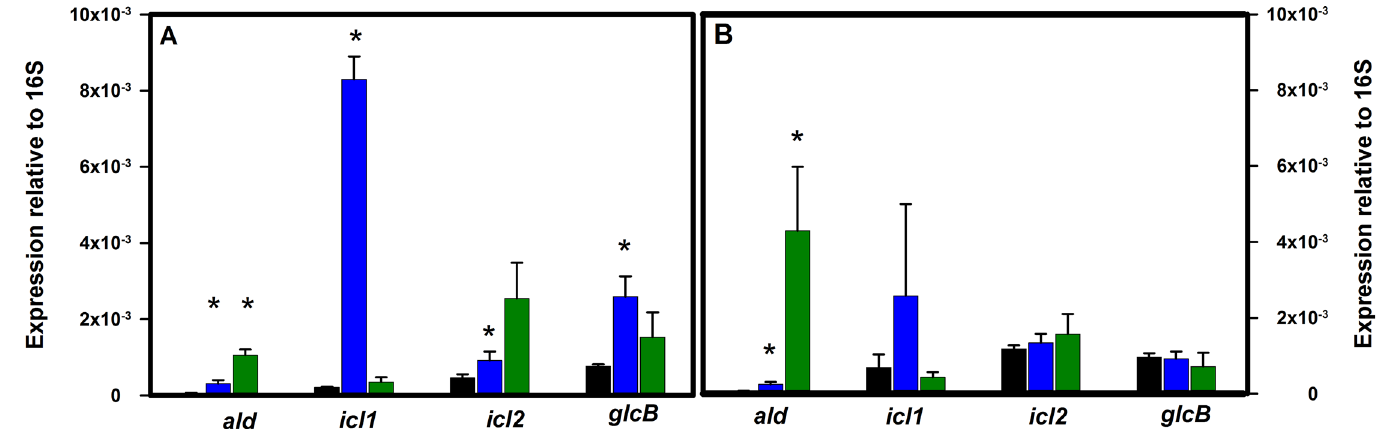
Fig 2. Expression of genes involved in the glyoxylate cycle. Total RNA from M . tuberculosis cultures in either aerobic; microaerobic NRP-1 or anaerobic NRP-2 was extracted and quantitation of transcripts performed. (A) H37Rv. (B) Erdman. Black bars – aerobic cultures. Blue bars – NRP-1, and green bars – NRP-2. RNA levels are expressed relative to the stable 16S rRNA. The standard deviation is shown. Asterisks indicate statistical significance (p < 0.05) of the comparison with the aerobic samples.